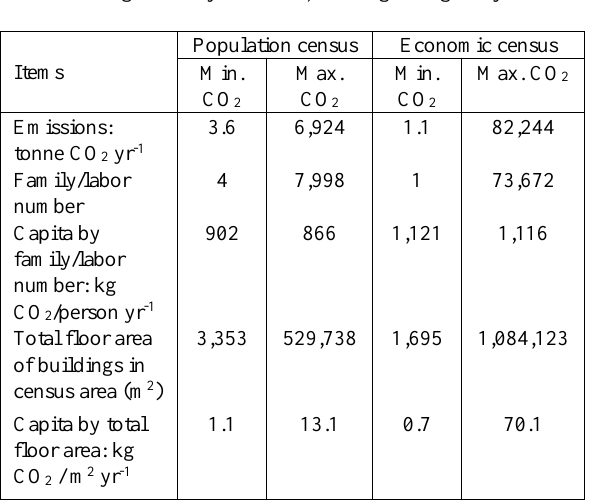
Figure 8. CO 2 maps on emissions from industrial & commercial buildings of Tokyo in 2014, unit: Gg CO 2 grid -1 yr -1